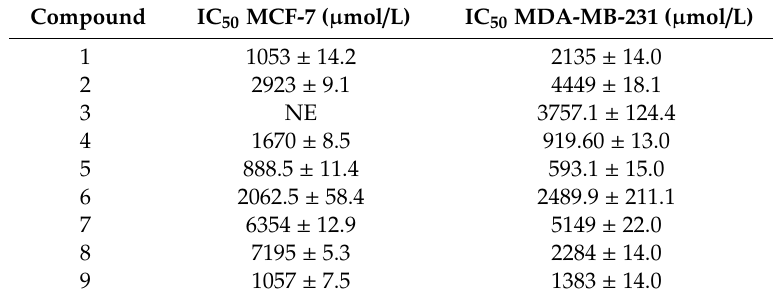
Table 1. The e ff ects of sulfonamide derivatives of metformin on [ 14 C] choline uptake in MCF-7 and MDA-MB-231 cells. The results (IC 50 values, µ mol / L) are presented as mean ± SD ( n = 3).